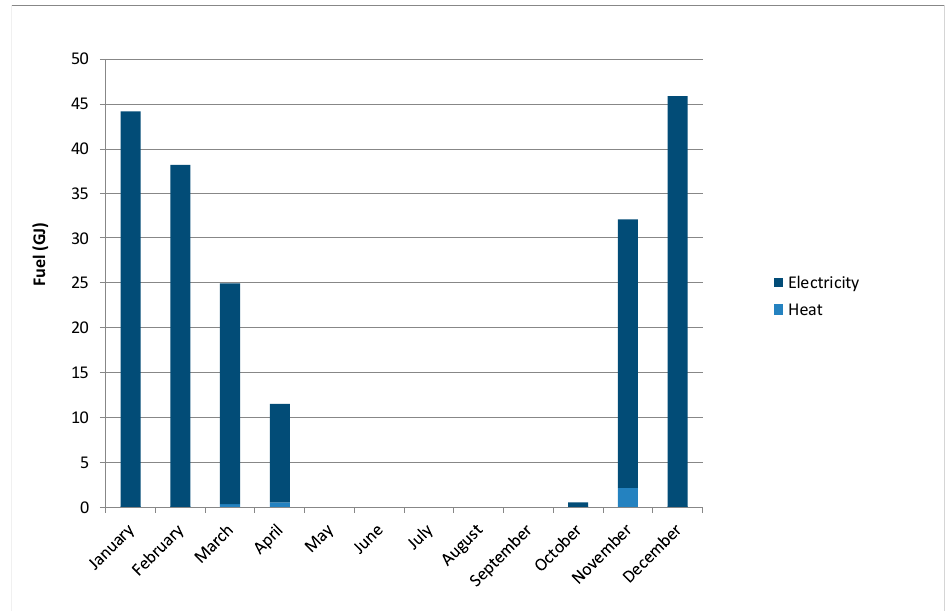
Figure 10. Seasonal storage: Product, irreversibility and efficiency.